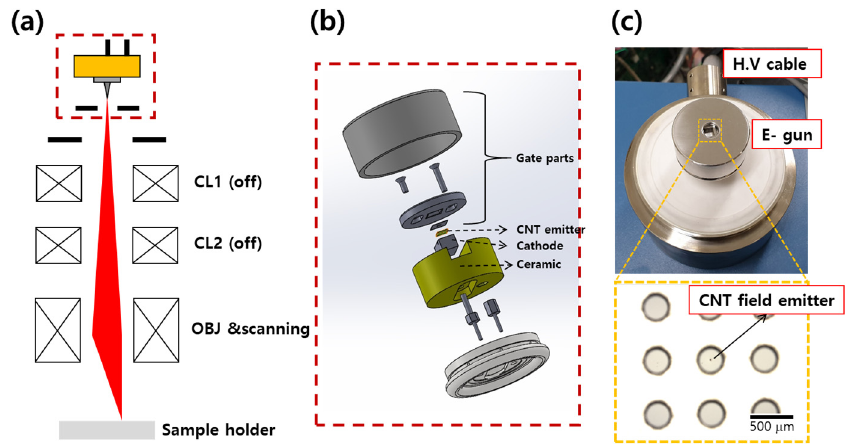
Figure 4. ( a ) Schematic diagram of normal SEM equipment with single CNT emission gun. ( b ) CNT electron gun cartridge. ( c ) Captured image of gun part and alignment with gate electrode and single CNT emitter.